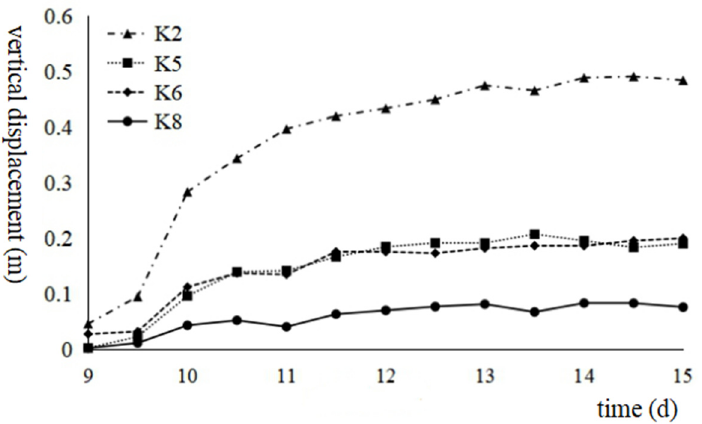
Figure 10. Vertical displacement of slope monitoring point.